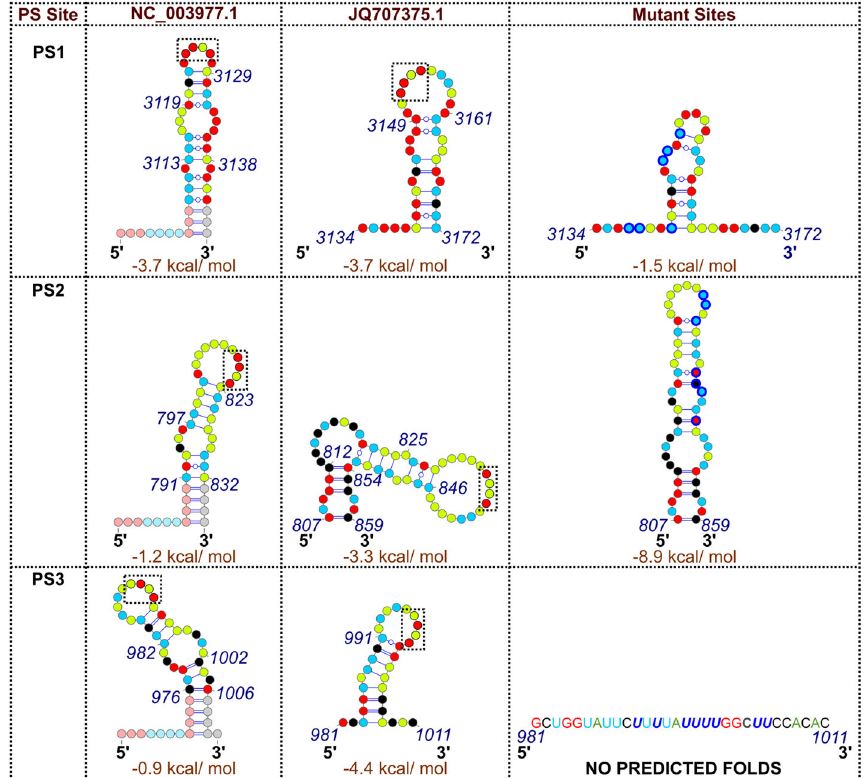
Fig. 2 Homologous PSs in the two HBV strains and their variants. HBV NC_003977.1 and JQ707375.1 PSs1-3, and their variant, sequences and Mfold secondary structures 12 . Faded nucleotides represent G:C clamps and 5 ′ -leaders used to force the NC_003977.1 sequences to adopt single folds and to facilitate dye-labelling 12 . Here and throughout, RNA nucleotides are shown as coloured dots (green — A, black — C, red — G, blue — U), Watson – Crick base pairs are indicated as lines, which are interrupted by circles for G – U pairs. The predicted folding free energies of the unliganded RNA fragments are also shown. These do not include the non-HBV sequences. -RGAG- motifs are shown boxed (black), and mutated nucleotides within PS variants are outlined in dark